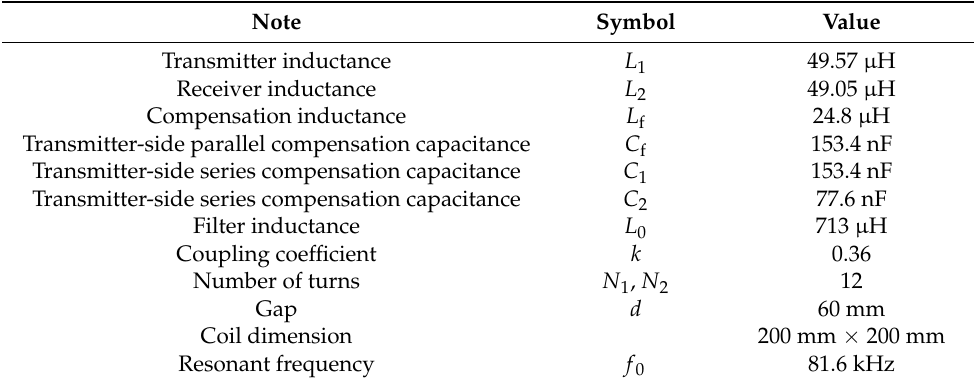
Figure 6. Experimental prototype. Table 1. System Specifications and Circuit Parameters.